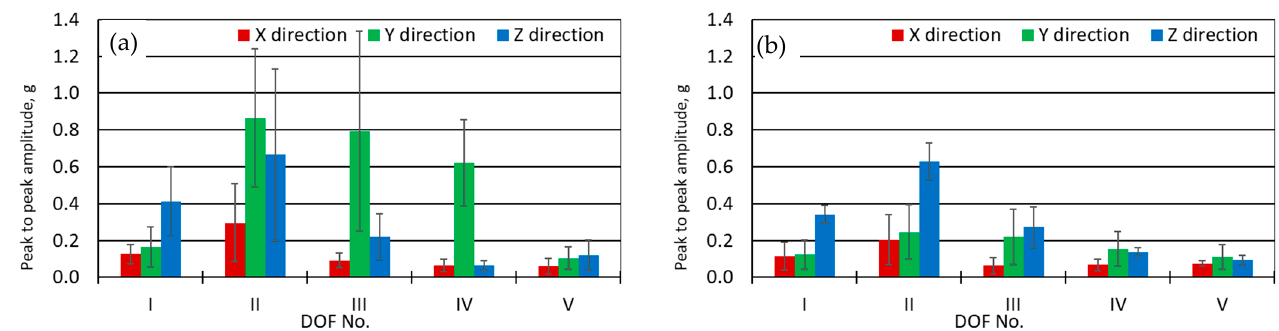
Figure 13. Settling time evaluated after rotation of separate joints in: ( a ) clockwise direction; ( b ) counterclockwise direction. Statistical evaluation was performed by Equations (8)–(13). Robots start position is shown in Figure 3a. From Figure 13a, it is seen that settling time had the greatest value in the x and y directions when joint II was rotated. When the robot joints move clockwise (Figure 13b), the longest settling time was recorded when rotating the second and third joints. The shortest settling time was detected while moving joint I and joint V in both cases. Results obtained from this experiment show that dynamic robot characteristics are mostly affected